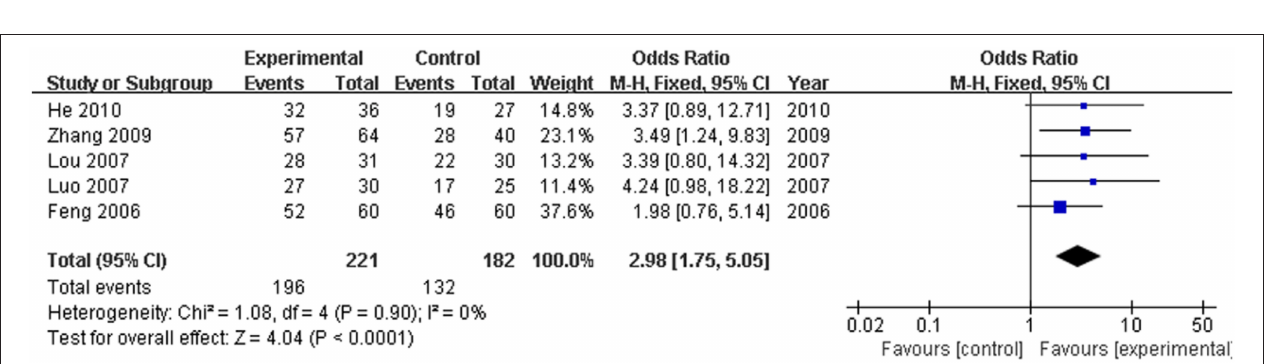
FIGURE 7 | Forest plot of γ -GT in treatment. (1) Study item displayed as the first author with the publication year. (2) The index of serum γ -GT was assessed in RCTs. (3) I-squared and P are the criterion of the heterogeneity test, (cid:7) pooled mean difference, — (cid:4) — mean difference, and 95% confidence interval.